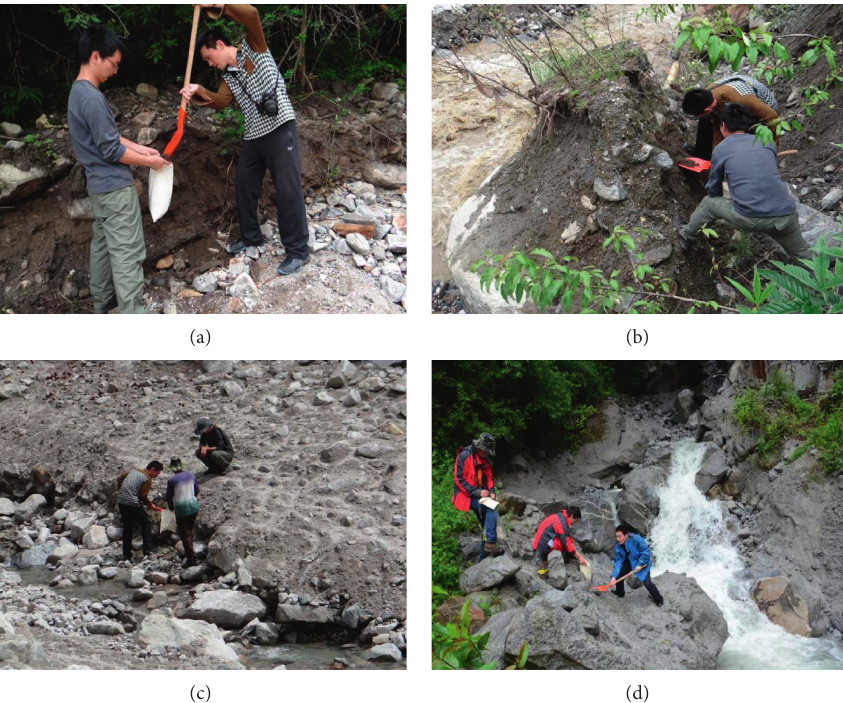
Figure 2: Site sampling process of glacial debris flow. (a) Qiemunongba. (b) Tianmogou. (c) Xingkongshanggou. (d) Dadanongba.